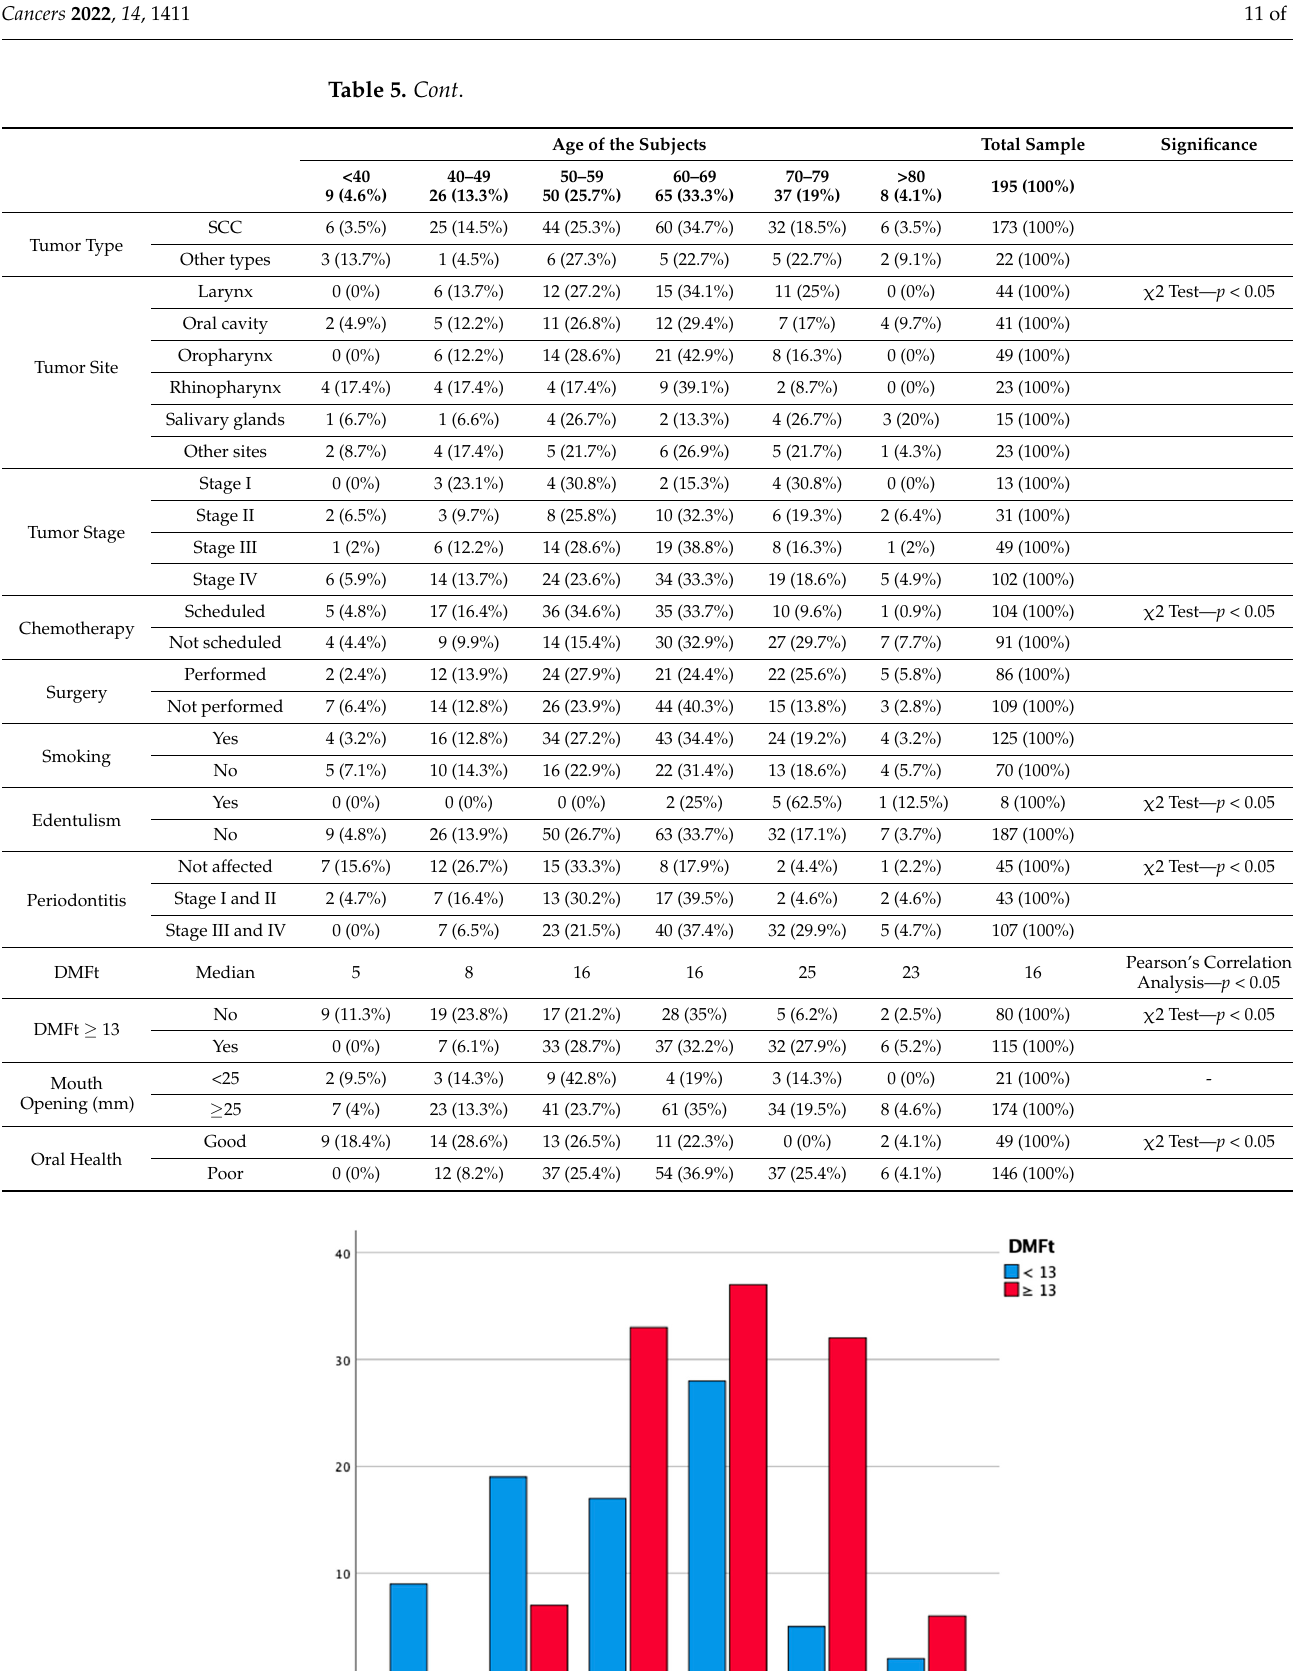
Figure 5. Distribution of DMFt < 13 according to age of the patients (in decades).